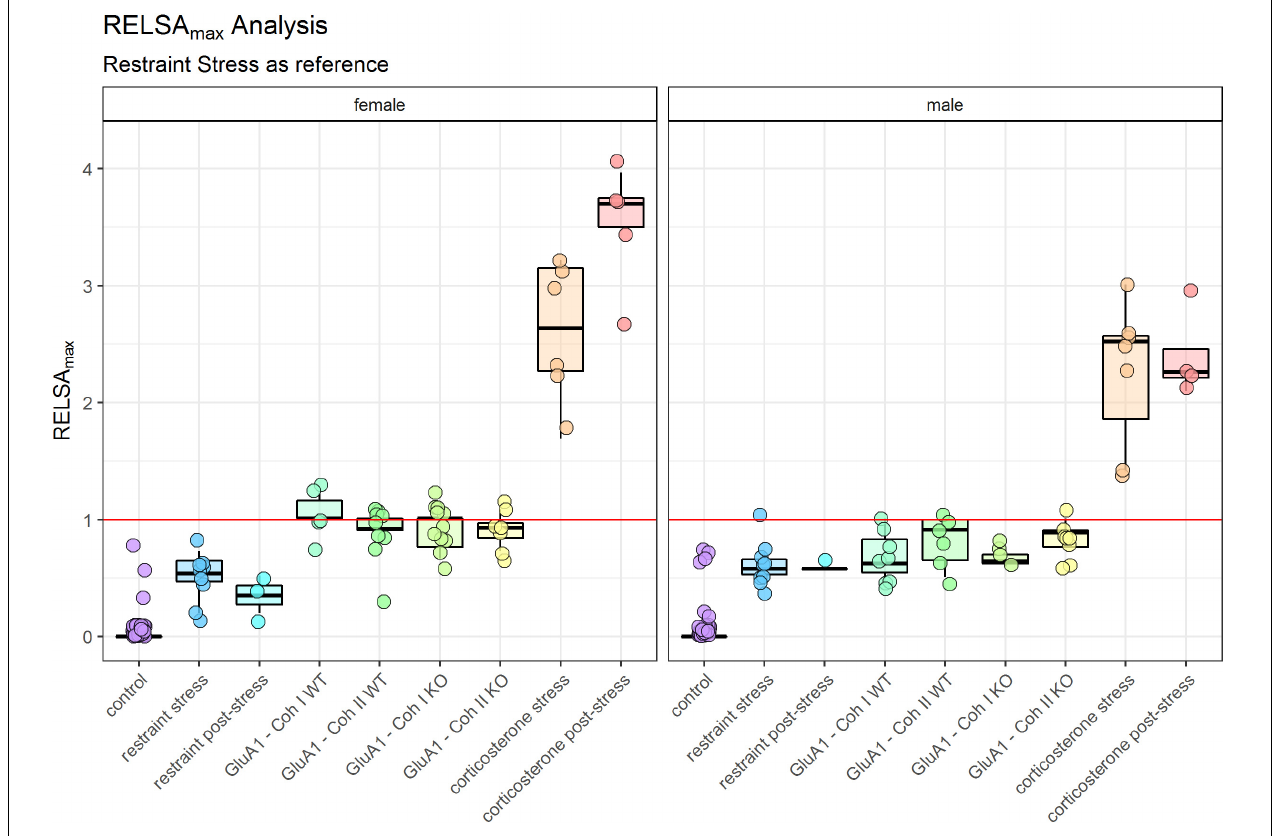
FIGURE 5 | RELSA max : comparison of the maximum severity throughout the experiment detected using the RELSA score. Restraint stress serves as reference. In addition, the RELSA includes body weight, burrowing performance, and fecal corticosterone metabolite concentrations. The red line indicates the reference maximum. Data was analyzed using RELSA in R, GluA1 KO experiment, except corticosterone n = ♀